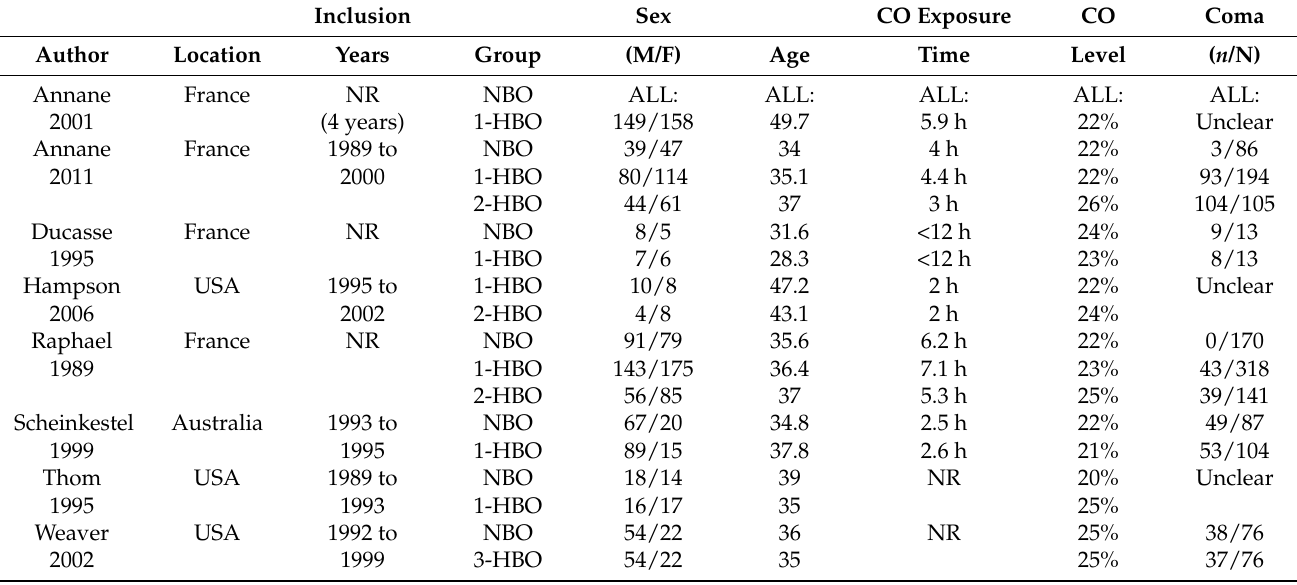
Table 1. Characteristics of the included randomized controlled